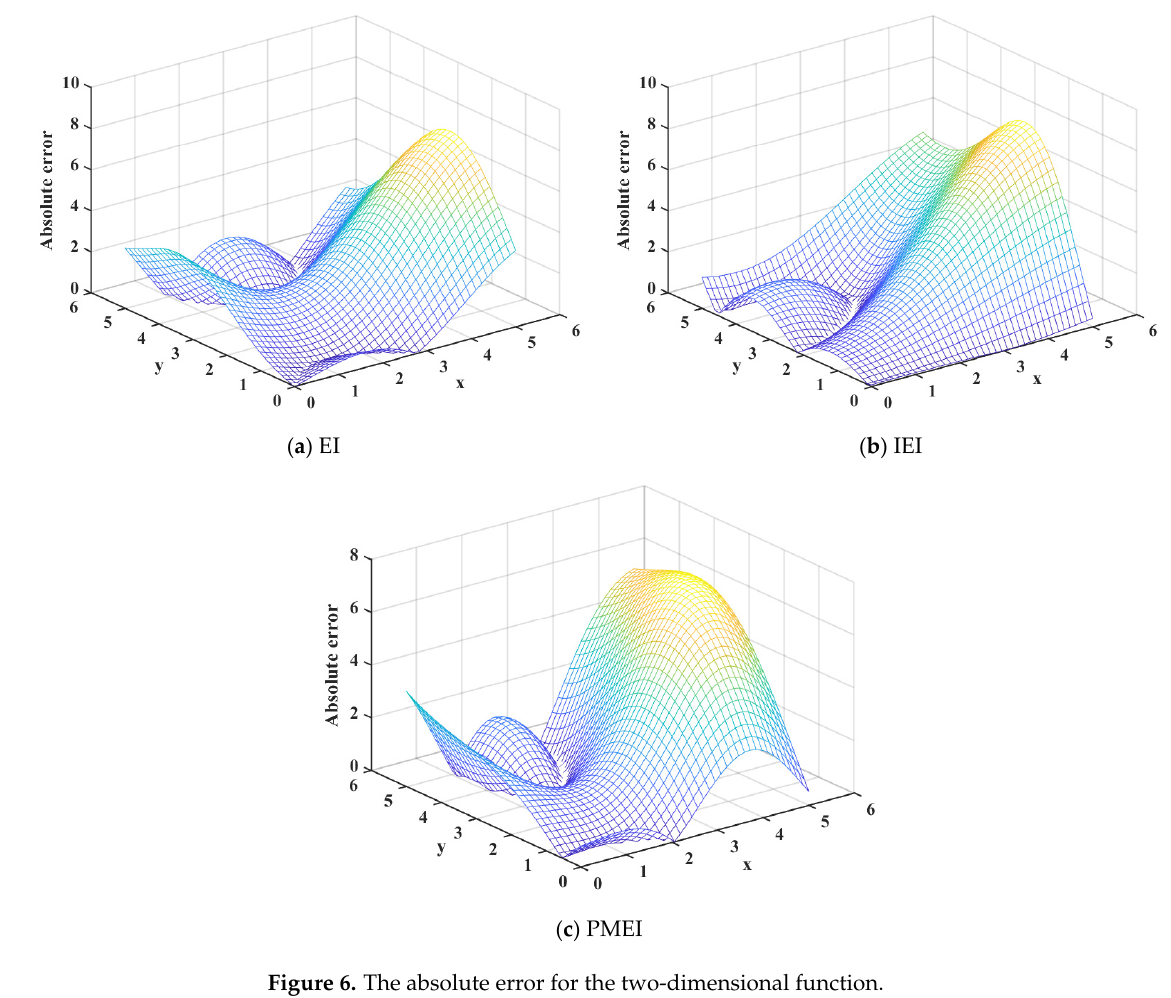
Figure 5. Test results on the predicted MSE for the two-dimensional function.